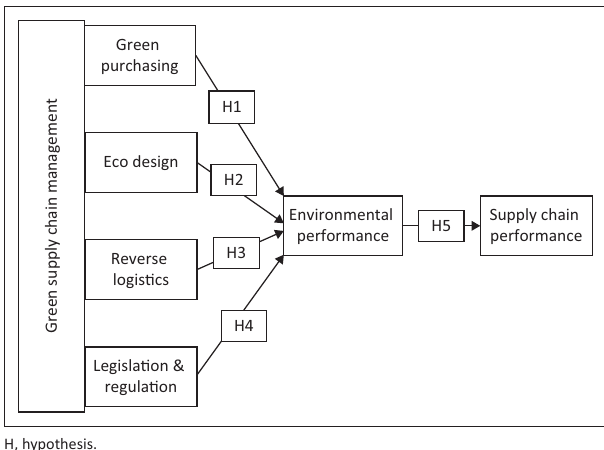
FIGURE 1: Conceptual model for green supply chain management, environmental performance and supply chain